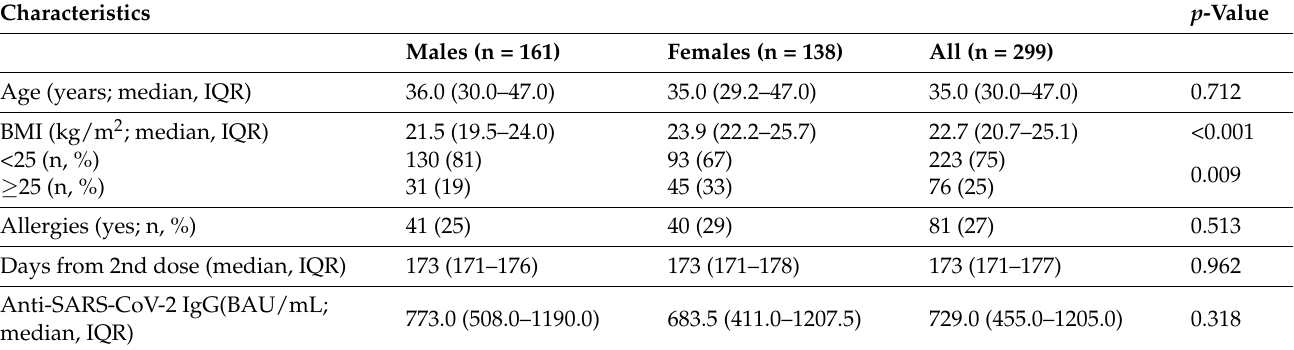
Table 1. Baseline characteristics based on